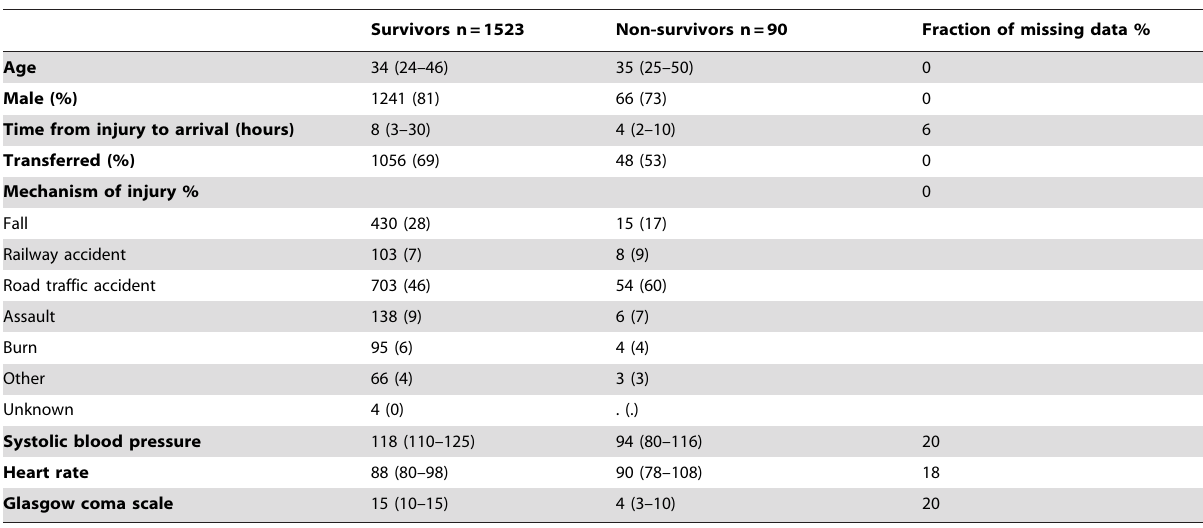
Table 1. Sample characteristics*.